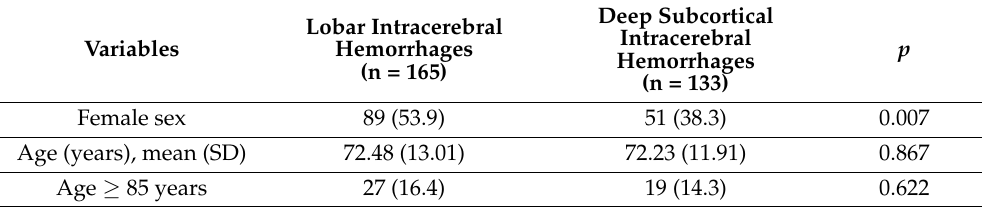
Table 2. Demographic data of patients with spontaneous acute lobar cerebral hemorrhages versus deep subcortical intracerebral hemorrhages.